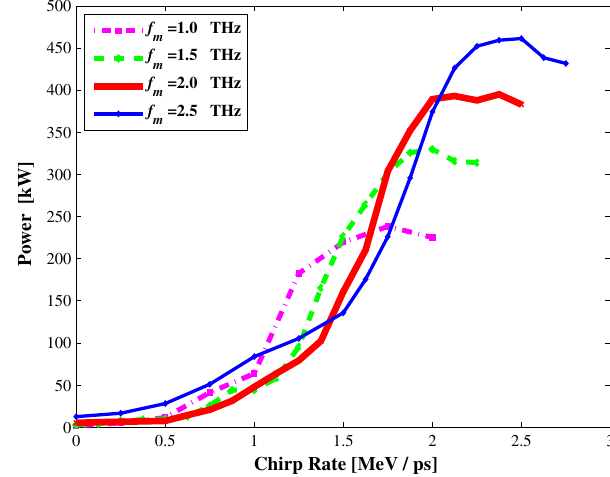
FIG. 13. Radiation power of prebunched FEL driven by a N m ¼ 2 long premodulated beam pulse with energy chirping. The beam charge is Q b ¼ 1 nC, the initial modulation depth is m ¼ 50% .